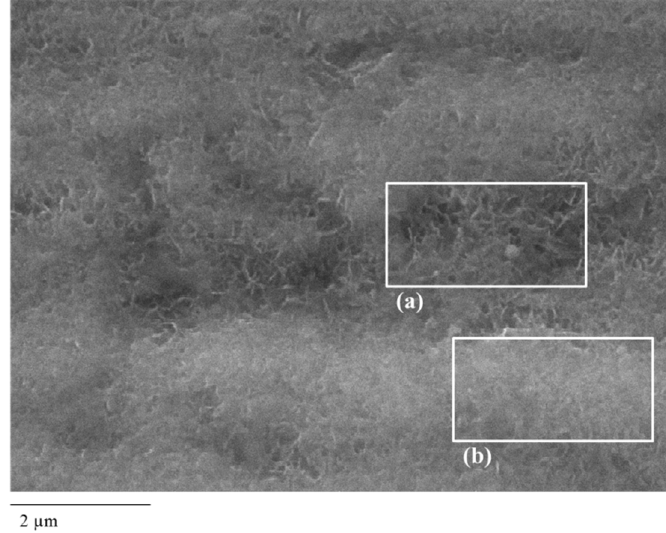
Figure 11. SEM image of SLS rod after 20 shear stress tests: the boxes evidenced ( a ) acicular nano layer and ( b ) highly deteriorated oxide layer.